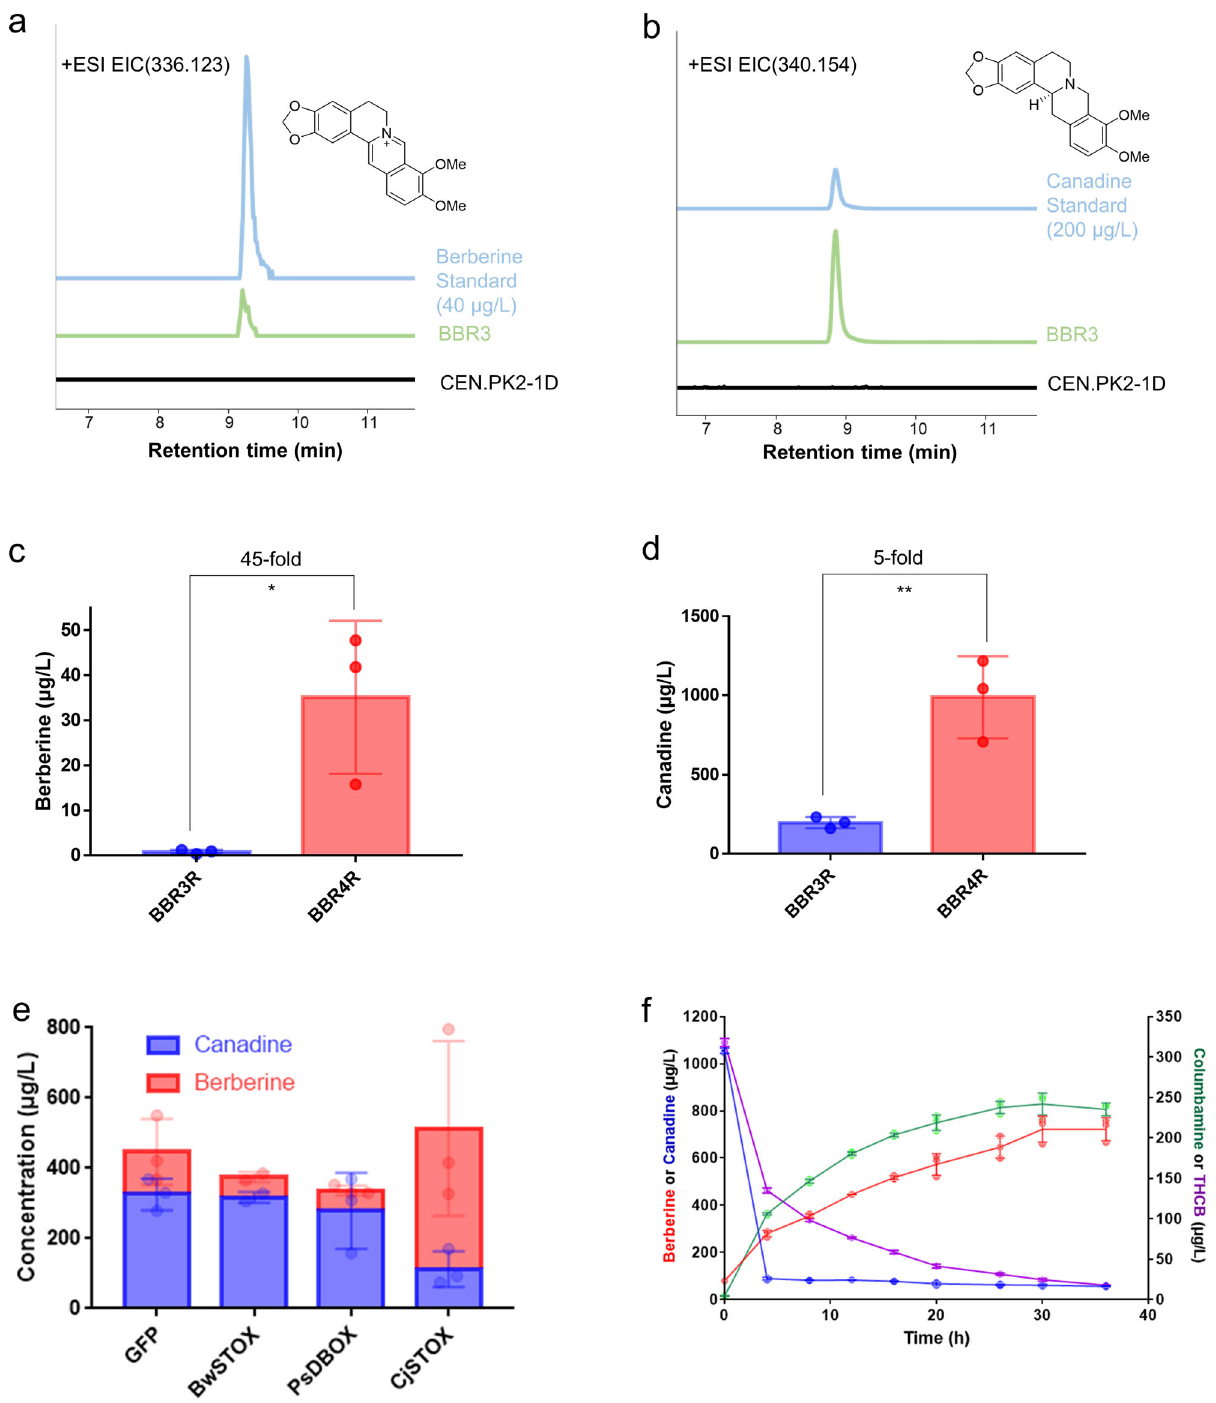
Fig. 2 Optimizations of the strain and bioprocess. Production of ( a ) berberine, and ( b ) canadine, in strain BBR3. Extracted ion chromatogram (EIC) of berberine (m/z 336.123) and canadine (m/z 340.154) are shown. Traces are representative of three biological replicates. Titer of ( c ) berberine, and ( d ) canadine, in optimized strain BBR4R compared with original BBR3R. Two-tailed t -test was used to calculate the p -value: * p < 0.05 and ** p < 0.01. e Screening of active STOX in N. benthamiana transient expression system with canadine in fi ltrated. f Increased concentration of berberine and possible intermediates under heating condition. Independent experiments, n = 3. Error bars represent standard